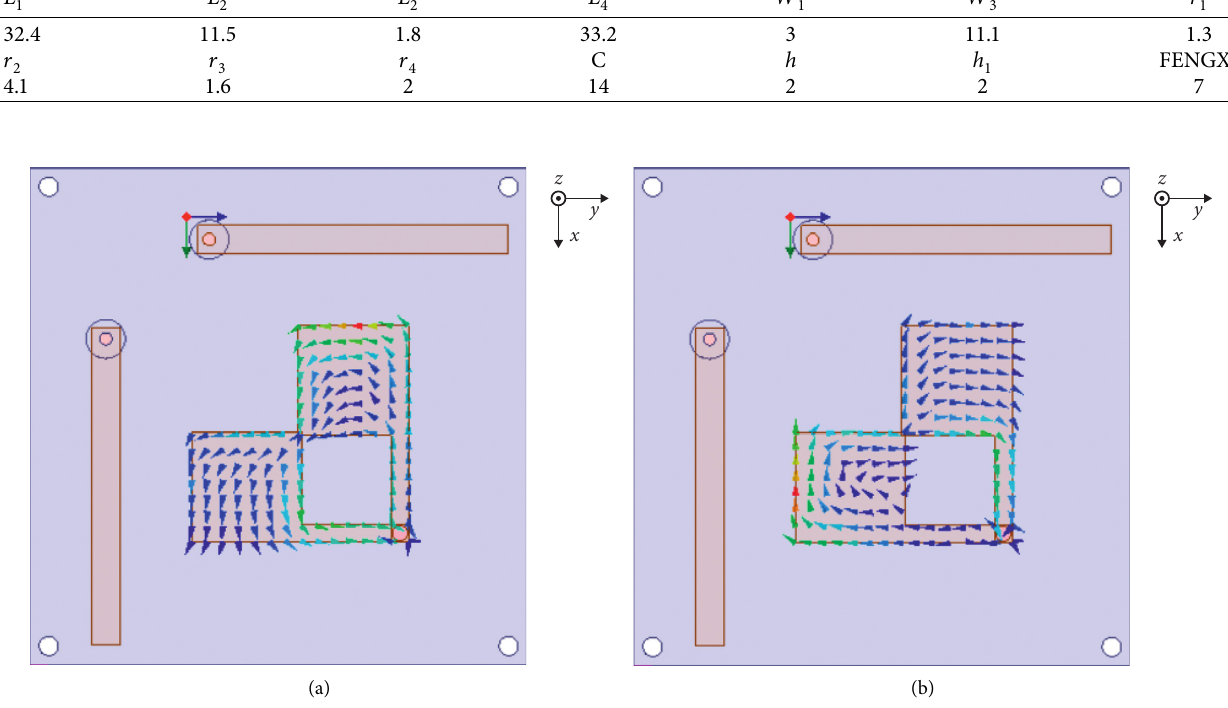
Figure 3: Current direction diagram: (a) port 1 and (b) port